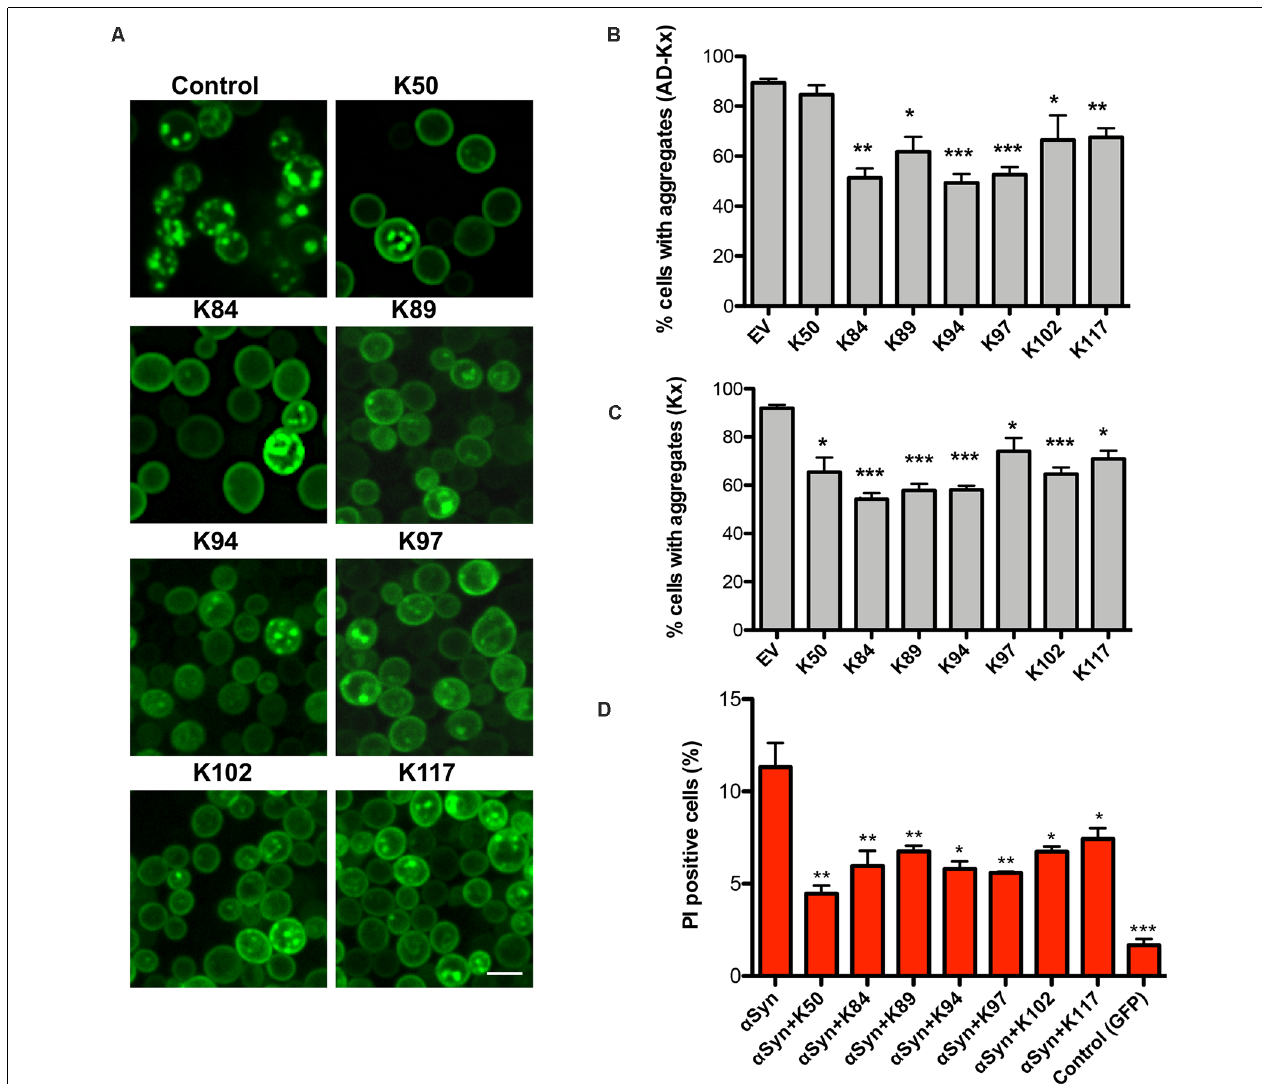
FIGURE 2 | Peptide-mediated reduction of α Syn-GFP aggregation and increased cell viability. (A) Life-cell microscopy 6 h after induction of GAL1 - α Syn-GFP expression in galactose-containing medium. Yeast cells (RH3468) were co-transformed with plasmids harboring the indicated peptide constructs under the constitutive GPD promoter or empty vector as a control. Scale bar: 2 µ m. Quantification of the percentage of cells with α Syn aggregates, co-expressing AD-peptide (AD-Kx) (B) or the peptides without AD (Kx) (C) . Significance of differences was calculated with t -test (* p < 0.05; ** p < 0.01; *** p < 0.001; n = 4). (D) Propidium iodide (PI) fluorescence intensity of yeast cells, expressing α Syn and indicated peptides after 24 h of induction was assessed by flow cytometry. Quantification of PI-positive cells with higher fluorescent intensities than the background 6 h after induction of α Syn expression. Cells expressing GFP were used as a negative control. Significance of differences was calculated with t -test relative to α Syn (* p < 0.05; ** p < 0.01; n =